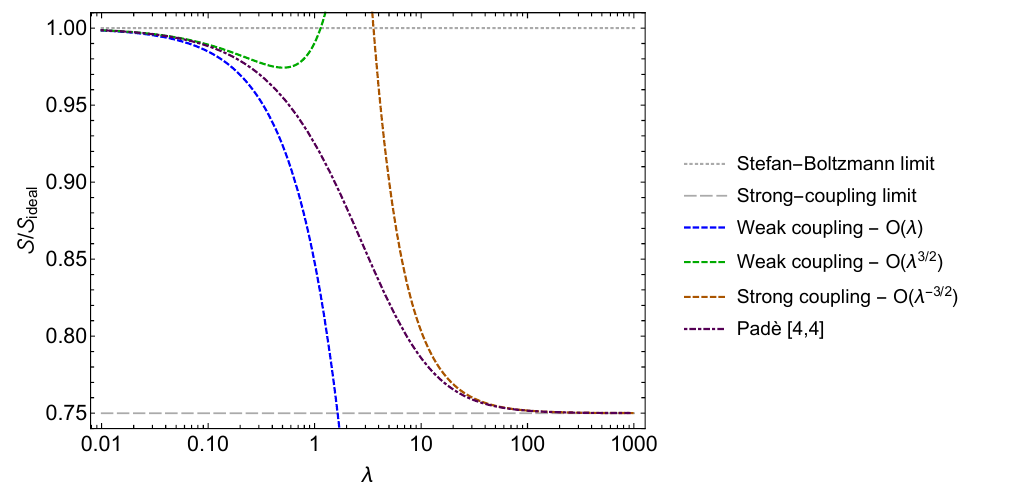
Figure 1 . Weak and strong coupling results for the entropy density in N = 4 SYM theory compared to a R Pad(cid:18)e approximation constructed from both [4 ; 4]